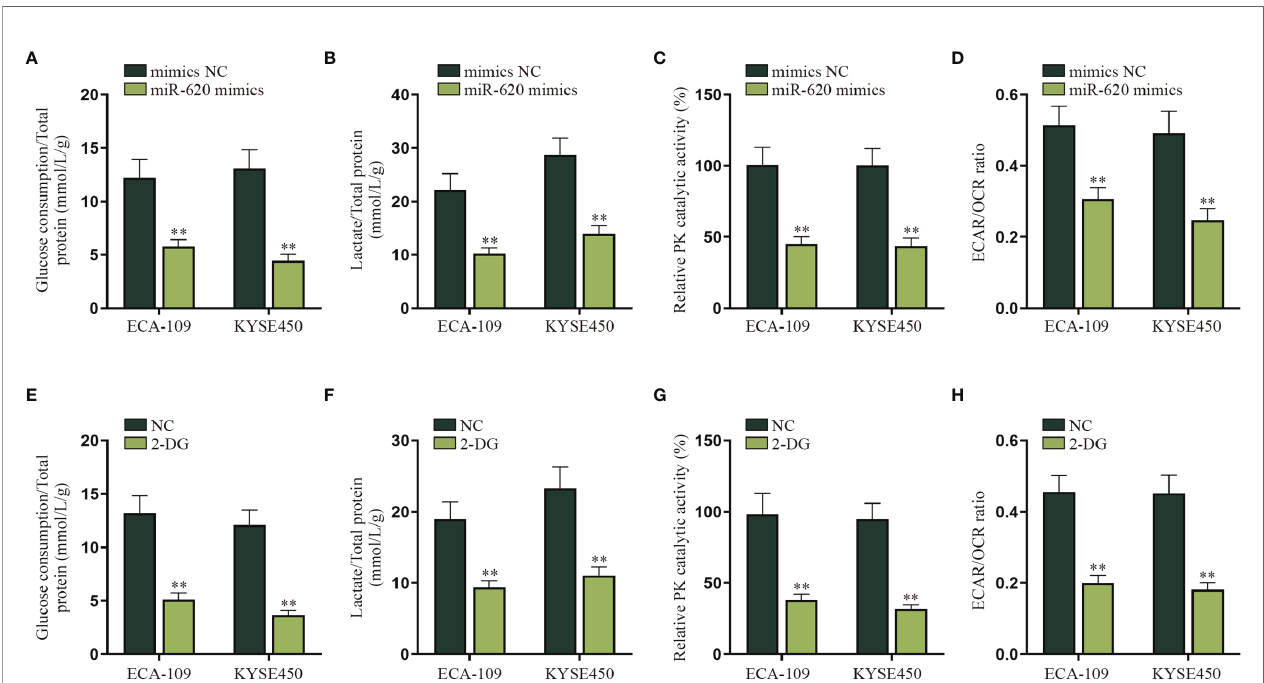
FIGURE 2 | MiR-620 inhibits the aerobic glycolysis of ESCC cells. (A) Glucose determination kit was applied to examine the glucose determination of ESCC cells transfected with miR-620 mimics. (B) Lactic acid determination kit was used to detect lactic acid content in ESCC cells upon miR-620 overexpression. (C) Pyruvate kinase activity assay kit was applied to measure the PK content in miR-620 mimic-transfected ESCC cells. (D) The ECAR/OCR ratio in miR-620 mimic-transfected ESCC cells was tested by Seahorese XF Extracellular Flux Analyzer. (E – H) ESCC cells were treated with 50 or 100 m M 2-DG (the glycolytic inhibitor) for 48 h, and the glucose consumption, total lactate protein, relative PK catalytic activity, and the ECAR/OCR ratio were respectively examined via qRT-PCR. ** p <